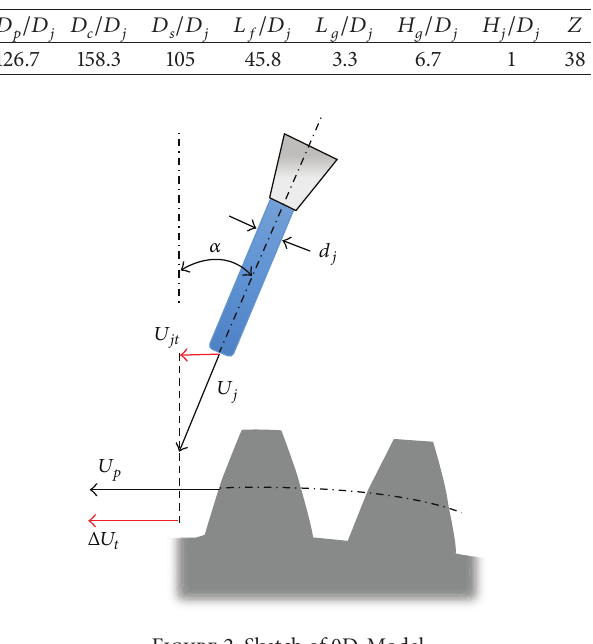
Table 1: Dimensionless geometrical parameters.